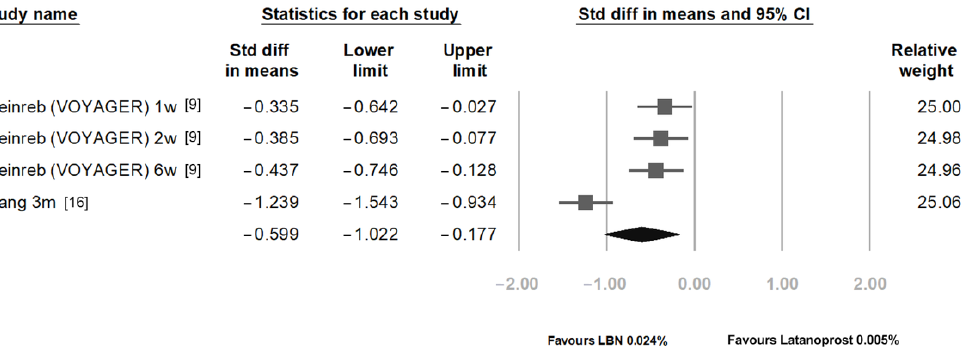
Figure 4. Comparison of IOP-lowering effects of latanoprostene bunod 0.024% and latanoprost 0.005%.